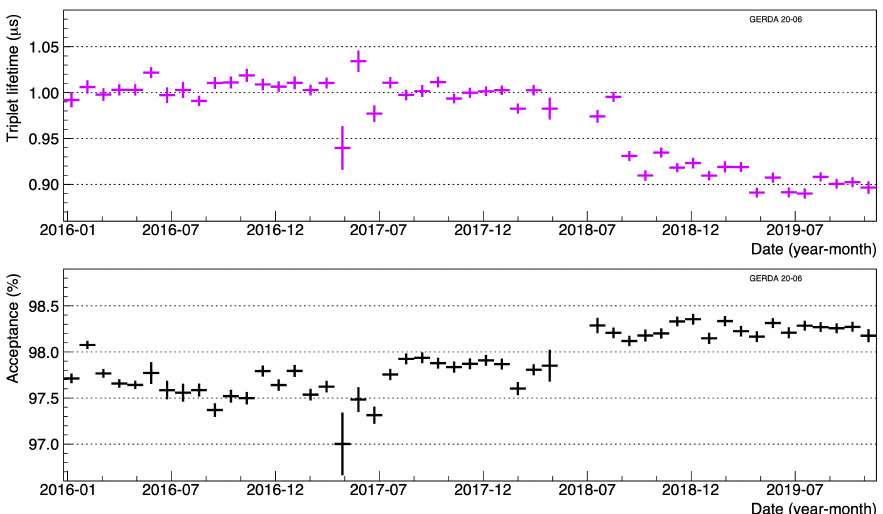
Figure 22. The LAr triplet half-life ( Top ) and the physical events acceptance of the LAr veto cut ( bottom ) along Phase